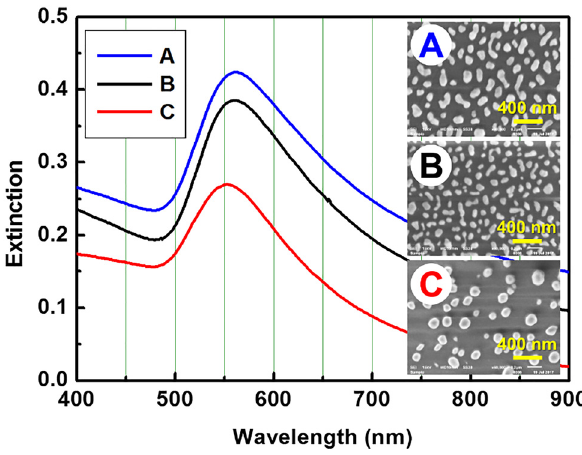
Figure 2: Optical extinction spectra measured on AuNP samples A , B , and C . The scanning electron microscope (SEM) images of A , B , and C are presented in the